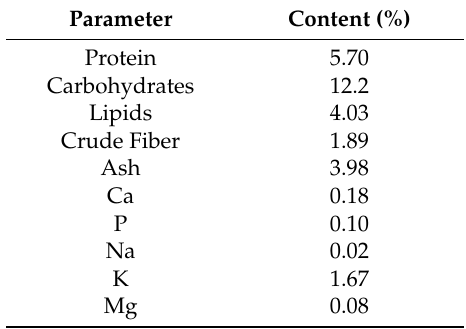
Table 2. Physico-chemical composition of banana with peel.